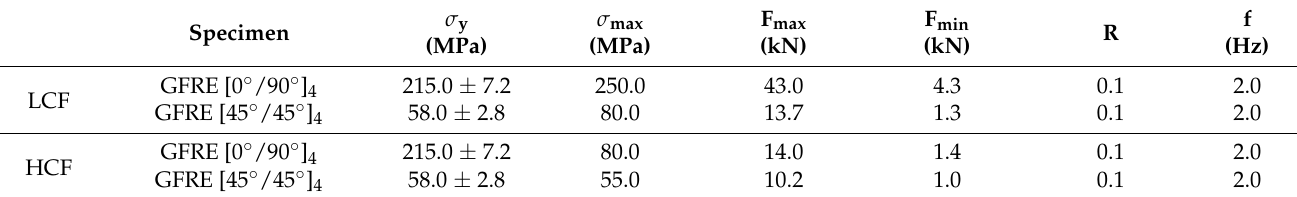
Based on the force and displacement variations of the impactor, the energy changes were calculated. Such changes represent the energy transfer from the projectile to the composite specimen. The energy change history for each impact test was determined by proper integrating the velocity change plots, i.e., the area under the curve representing these changes. In the test, the absorbed energy was determined as a fraction of the energy transferred from the projectile to the composite specimen at the end of the impact, and in each case the impact energy corresponded to the kinetic energy of the projectile just before the impact. Although the maximum force, contact duration, history of force and displacement changes and energy are important characteristics of composite laminates subjected to dynamic loads, only the change in the amount of energy absorbed was the main parameter considered in the experiment. For this reason, studies were carried out on the influence of fatigue load on impact toughness, and especially its negative effect in the form of an increase in energy dissipation due to the loss of stiffness. Impact resistance was quantified on the basis of the analysis of the maximum impact force F i and the corresponding displacement U, as well as the absorbed energy E a and the penetration threshold. In order to visualize the type and extent of damage, microstructural tests were carried out with the use of SEM (JOEL Ltd., Akishima, Japan) and CT scan